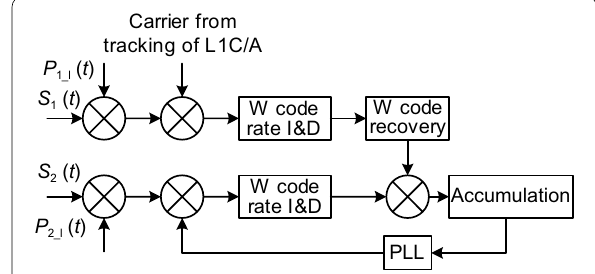
Fig. 1 Digital signal processing structure of the z-track method. Spreading code of L2P(Y) is estimated and accumulated through stable tracking of L1C/A